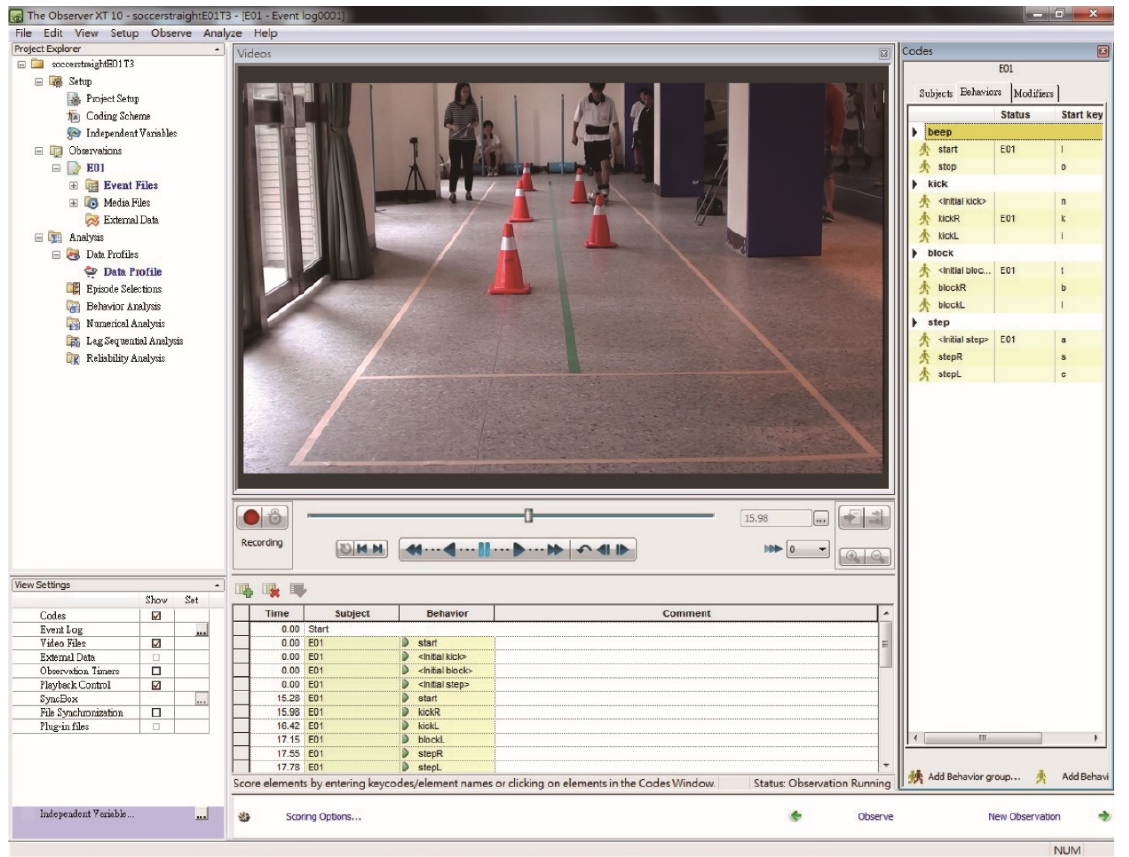
Figure 1. The software interface and the flow grid of the testing instrument.